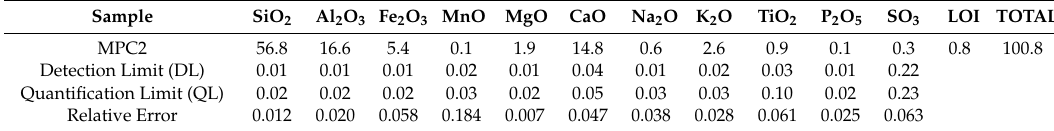
Table 1. Chemical composition of original brick MPC2 (wt %) by X-ray fluorescence (XRF) (modified from [5]).